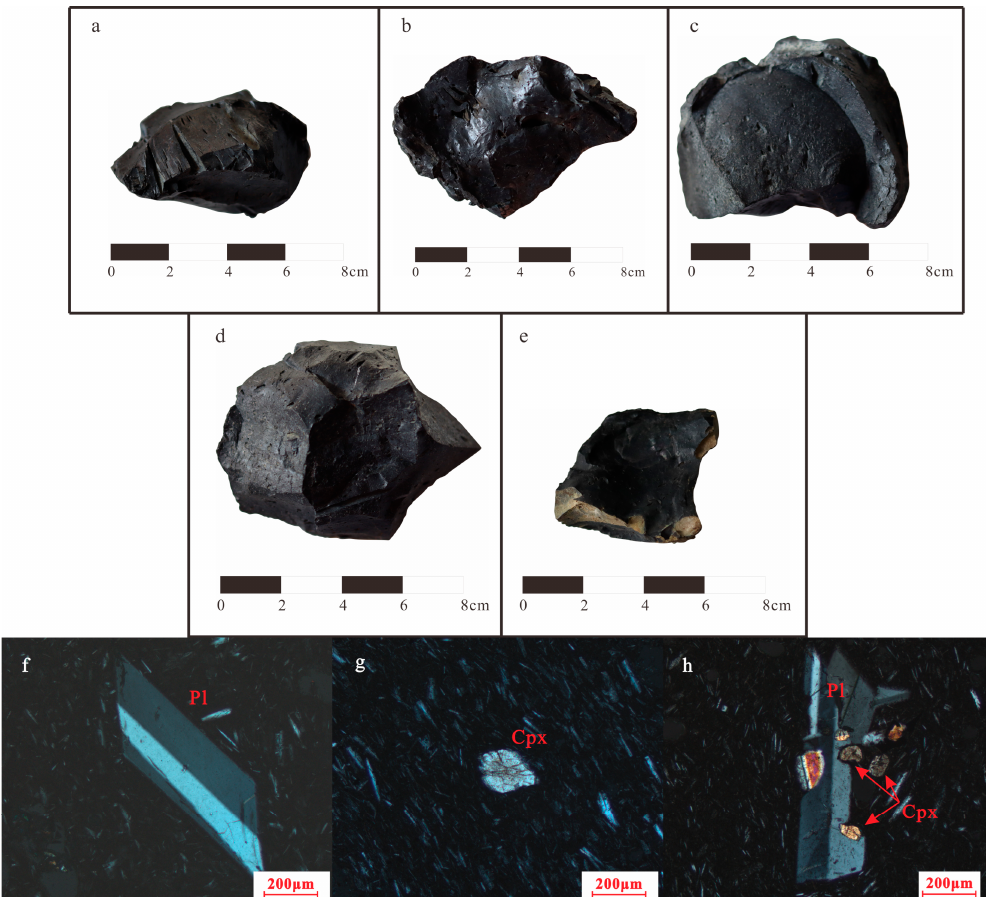
Figure 2. Hand specimens of dacite from ( a ) TVG 7; ( b ) TVG 8; ( c ) TVG 9; ( d ) TVG 10; ( e ) TVG 12; and transmitted light images of phenocrysts in dacite from ( f ) and ( g ) TVG 9; ( h ) TVG 10 in the Eastern Manus Basin. Abbreviations: Pl—plagioclase, Cpx—clinopyroxene. The sample hand specimens are black in color and porphyritic, with phenocryst con- tents <5 vol.%, mainly composed of plagioclase, pyroxene, and minor magnetite. The sample thin sections were observed using a polarized light microscope. The sizes of phe- nocrysts are 50 − 600 µ m, and they exhibit euhedral to subhedral texture; the matrix is composed of acicular plagioclase micro-crystals, granular pyroxene micro-crystals, and minor granular magnetite micro-crystals with pilotaxitic texture (Figure 2f–h). According to the back-scattering images of the thin sections, apatites exist primarily as micro-crystals in the host dacite, and partly as inclusions in plagioclase, pyroxene, and magnetite phe- nocrysts, implying the presence of early apatite-saturation in melts (Figure 3a–c) [42]. The apatite micro-crystals in the matrix have a size of ~20 µ m, mostly exhibiting equant to sub-equant crystals in euhedral-subhedral texture, and showing uniformly bright surfaces without mineral- or fluid-inclusions (Figure 3d–g), indicating that no hydrothermal replace- ment has occurred. A very few apatites are highly acicular and large (maximum elongation along the c-axis to more than 300 µ m, as in Figure 3h,i), which may precipitate during a rapid quench